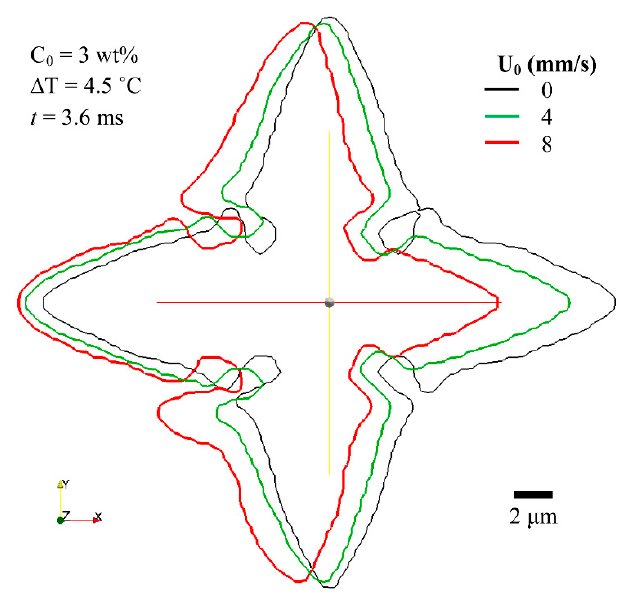
Figure 13. Effect of melt velocity on the morphology of Al-3 wt % Cu dendrites. Different colors represent different melt velocities at the inlet: 0 mm/s, 4 mm/s, and 8 mm/s.